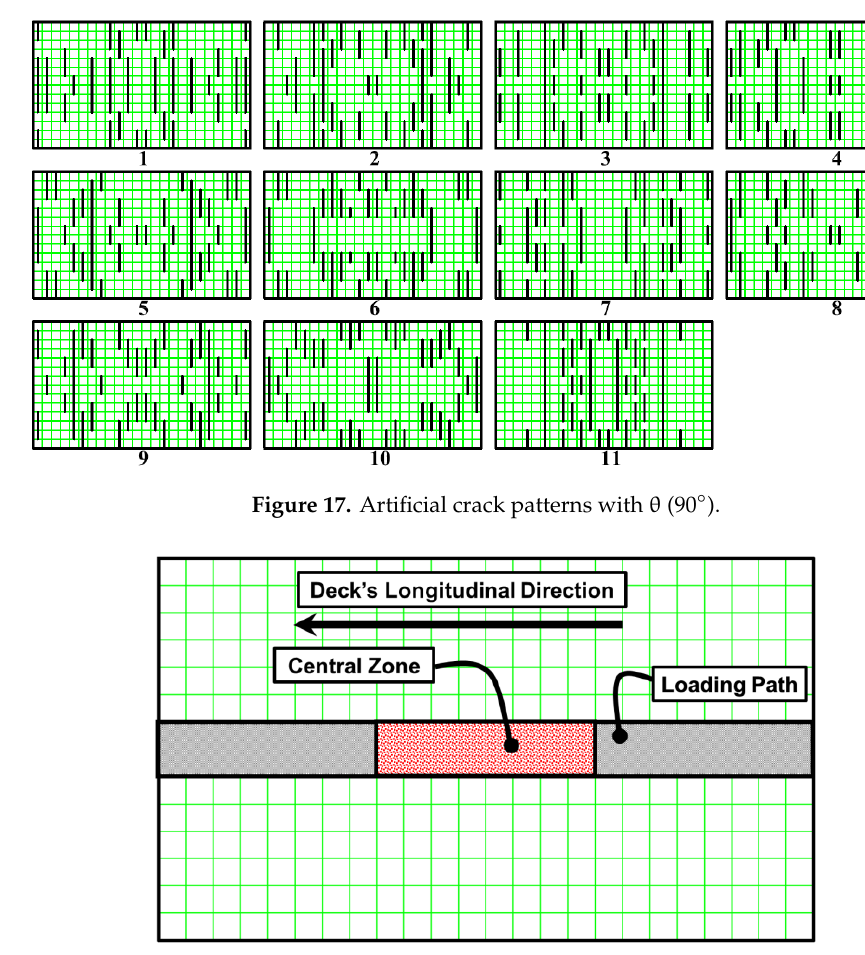
Figure 18. Finite element mesh of the bottom surface of the deck.